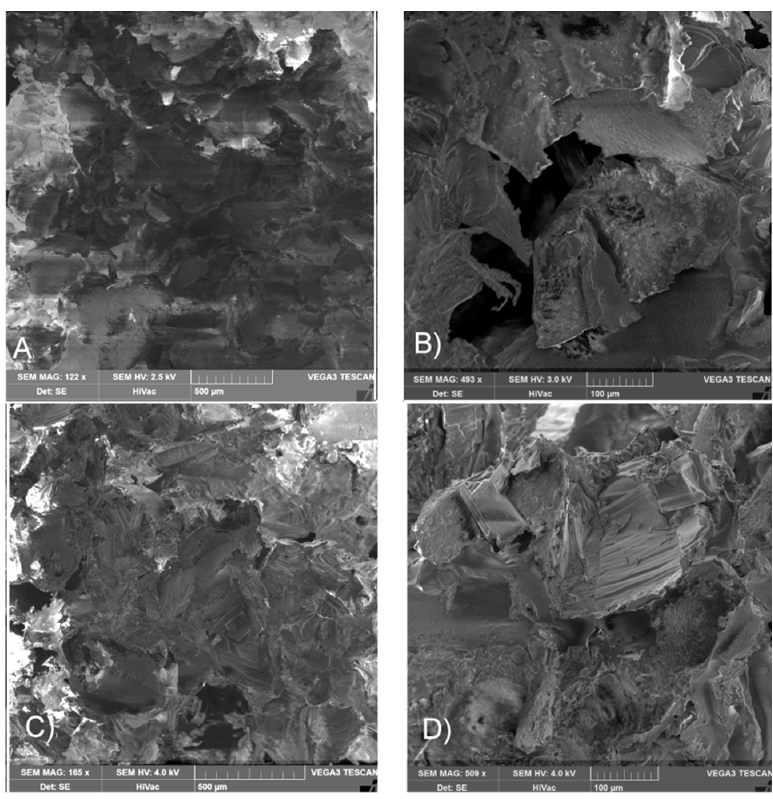
Figure 3. SEM pictures of porous surface of scaffold LGT40 C; ( A , B ) before sterilization and ( C , D ) after γ sterilization with irradiation dose of 25 kGy.